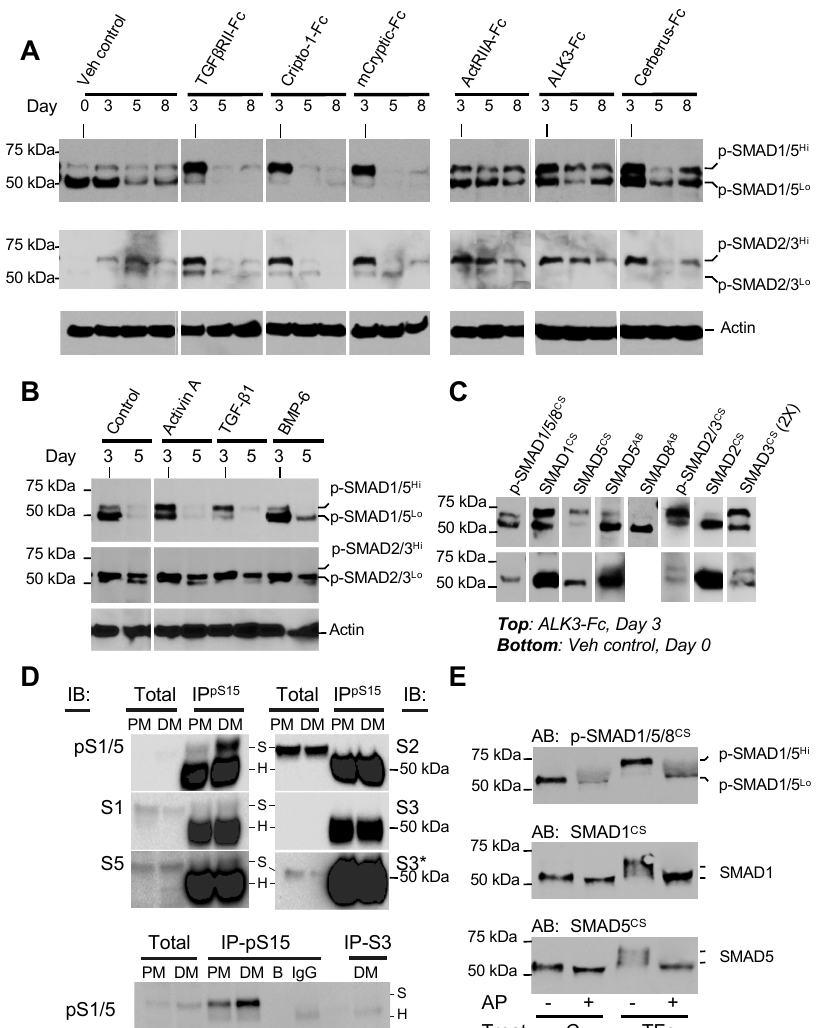
Figure 5. Altered SMAD activities and electrophoretic mobility shift in p-SMAD1/5 associate with anti-adipogenic mechanism. ( A ) Anti-p-SMAD Western blots of whole cell lysate show C-terminal Serine phosphorylation of SMADs (top panel: p-SMAD1/5/8, middle panel: p-SMAD2/3) in samples treated with different ligand traps or vehicle (PBS). Treatments were started at day 0 of differentiation and samples were collected at days 3, 5, or 8 of differentiation as noted. Two p-SMAD1/5/8 forms were detected and are labeled p-SMAD1/5 Lo and p-SMAD1/5 Hi , reflecting differences in electrophoretic mobility. Similarly, p-SMAD2/3 also appears as two bands. Actin Western blots were used as sample loading controls. Blots were loaded with 10 µ g protein per lane. Quantification is shown in Figure S3. Total SMAD loading controls are shown in Figure S4. ( B ) Anti-p-SMAD Western blots of whole cell lysate show C-terminal Serine phosphorylation of SMADs (top panel: p-SMAD1/5/8, middle panel: p-SMAD2/3) in samples treated with different ligands and Fc control (ALK3-Fc). Treatments were started at day 0 of differentiation. Samples were loaded at a 3-fold higher amount than in panel A to make up lower detection or lower abundance issues. Samples were collected at days 3 or 5 of differentiation. Actin was used as loading control. Blots for Actin and p-SMAD1/5/8 have 10 µg protein per lane. The p-SMAD2/3 blot has 30 µg protein per lane. Quantification is shown in Figure S3. Total SMAD loading controls are shown in Figure S5. Figure S6 shows receptor levels. ( C ) Anti-SMAD Western blots of whole cell lysate show overall SMAD levels in ALK3-Fc treated samples (top panel, sample collected at day 3) and vehicle control samples (PBS, bottom panel, sample collected at day 0). ALK3-Fc was used as positive control as both p-SMAD1/5 Lo and p-SMAD1/5 Hi forms were prominently visible with this treatment. Antibodies used are noted above the blots. CS denotes an antibody from Cell Signaling Technologies, AB denotes an